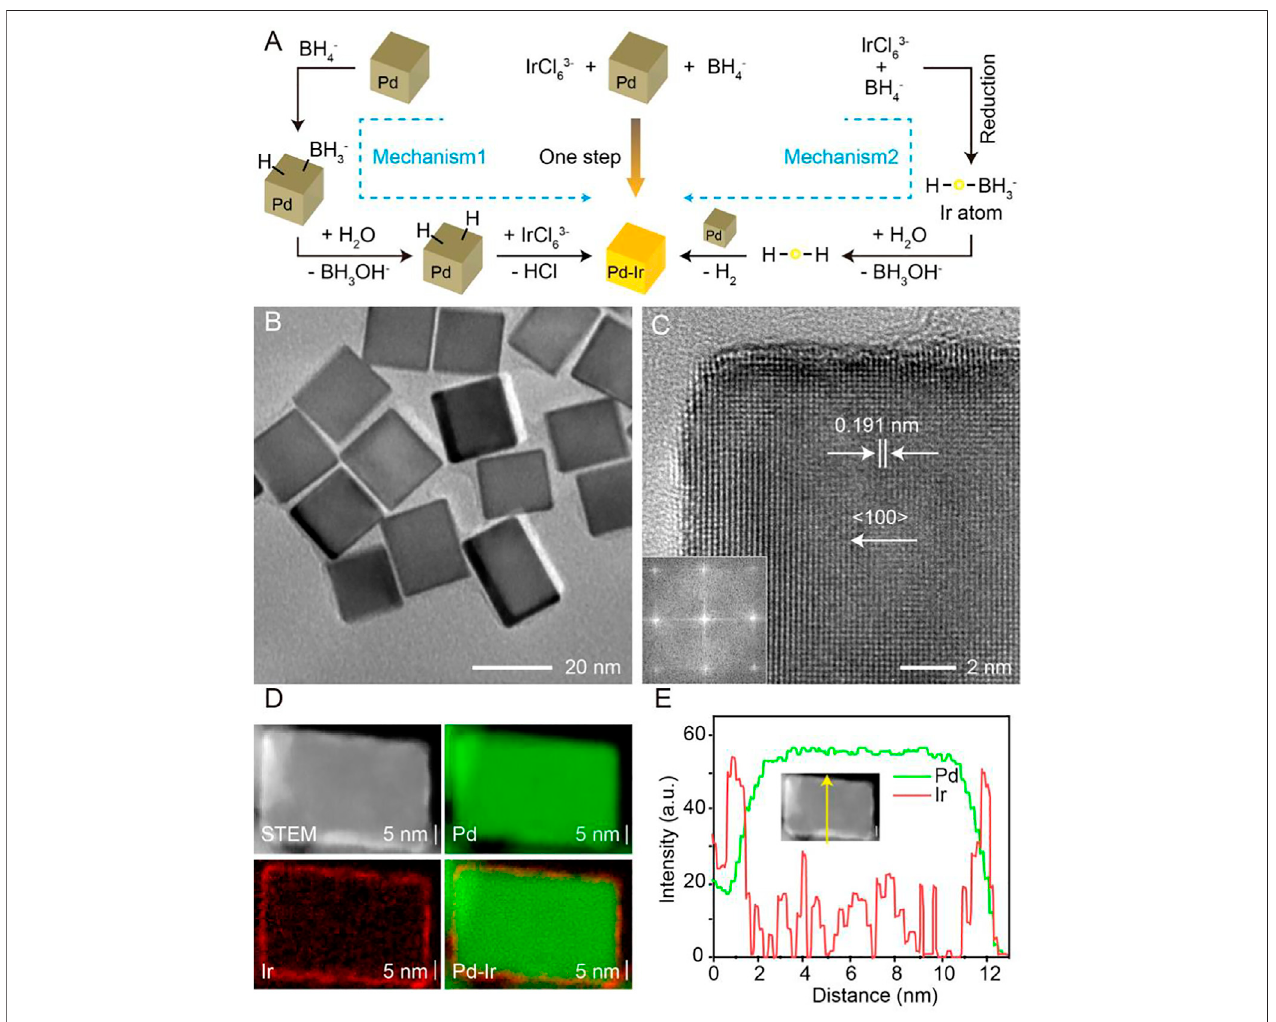
FIGURE 1 | (A) Scheme showing the mechanism of synthesis of Pd-Ir nanocubes. (B) The TEM image of Pd-Ir nanocubes. (C) The HRTEM image (inset: corresponding Fourier transform pattern) of a corner region of a Pd-Ir nanocube. (D) The HAADF-STEM image and EDX maps of a Pd-Ir nanocube. (E) Linear EDX analysis of a Pd-Ir